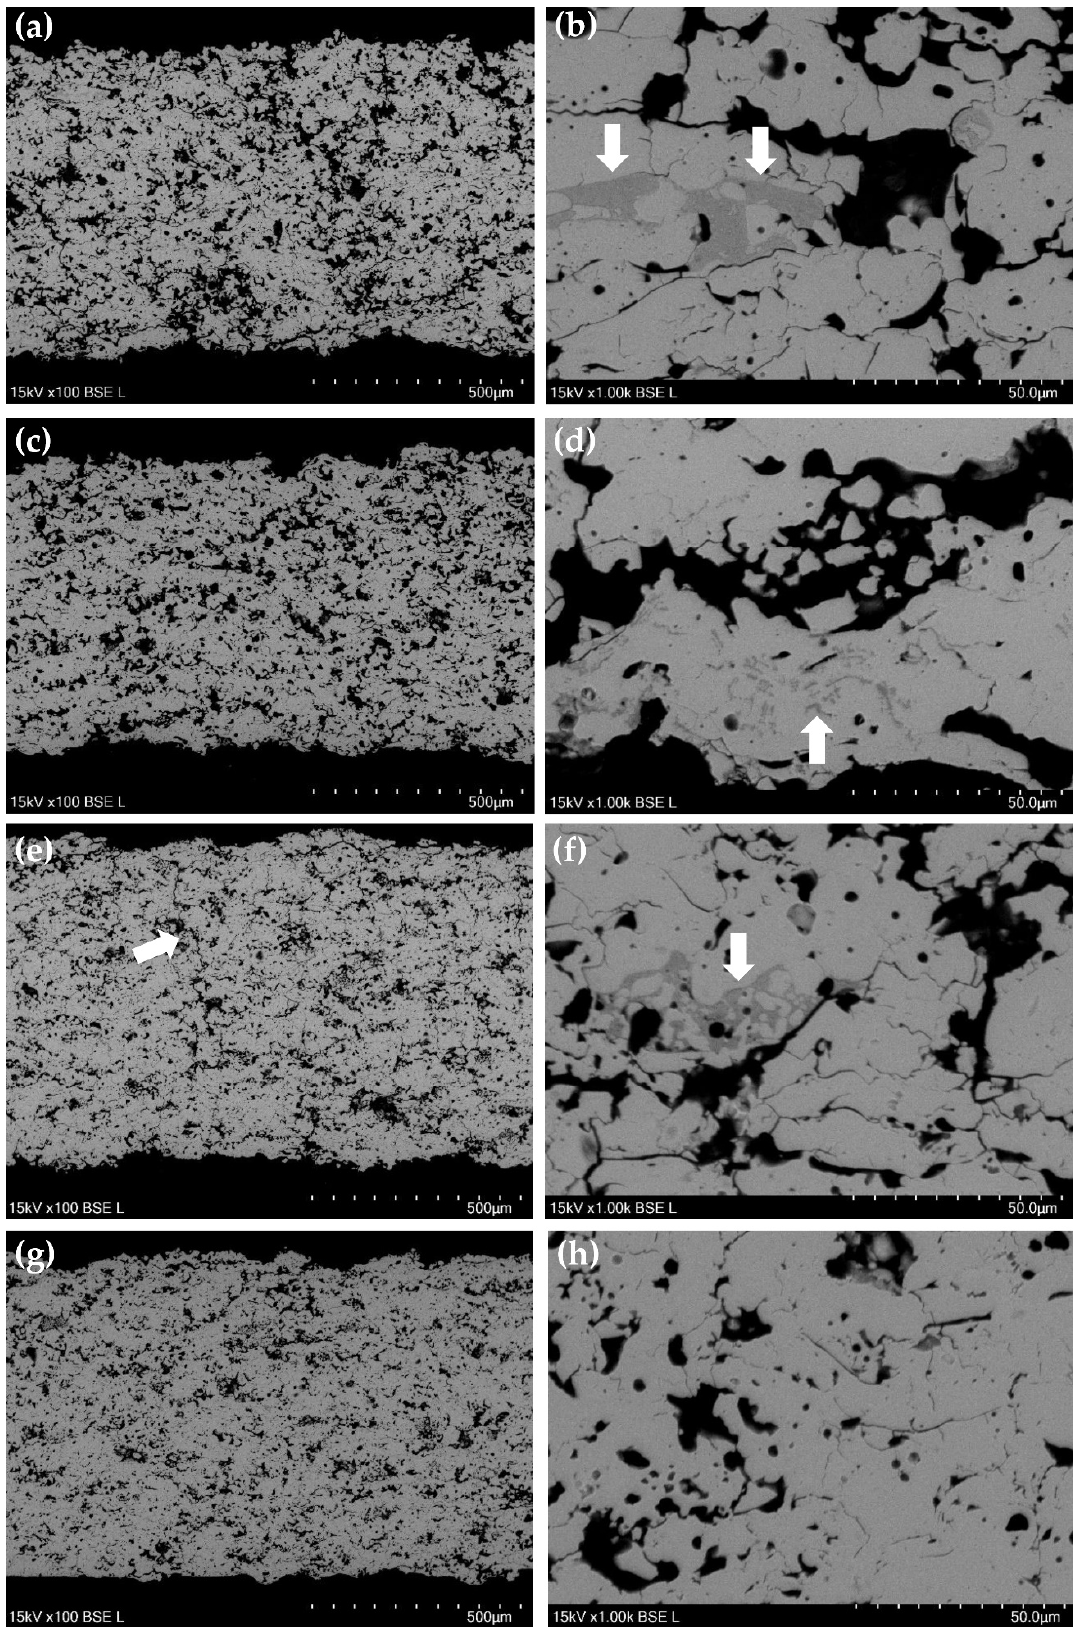
Figure 12. SEM Micrographs, Reference coating after FCT ( a , b ) and 400 h heat treatment ( c , d ), Commercial coating after FCT ( e , f ) and 400 hours heat treatment ( g , h ).